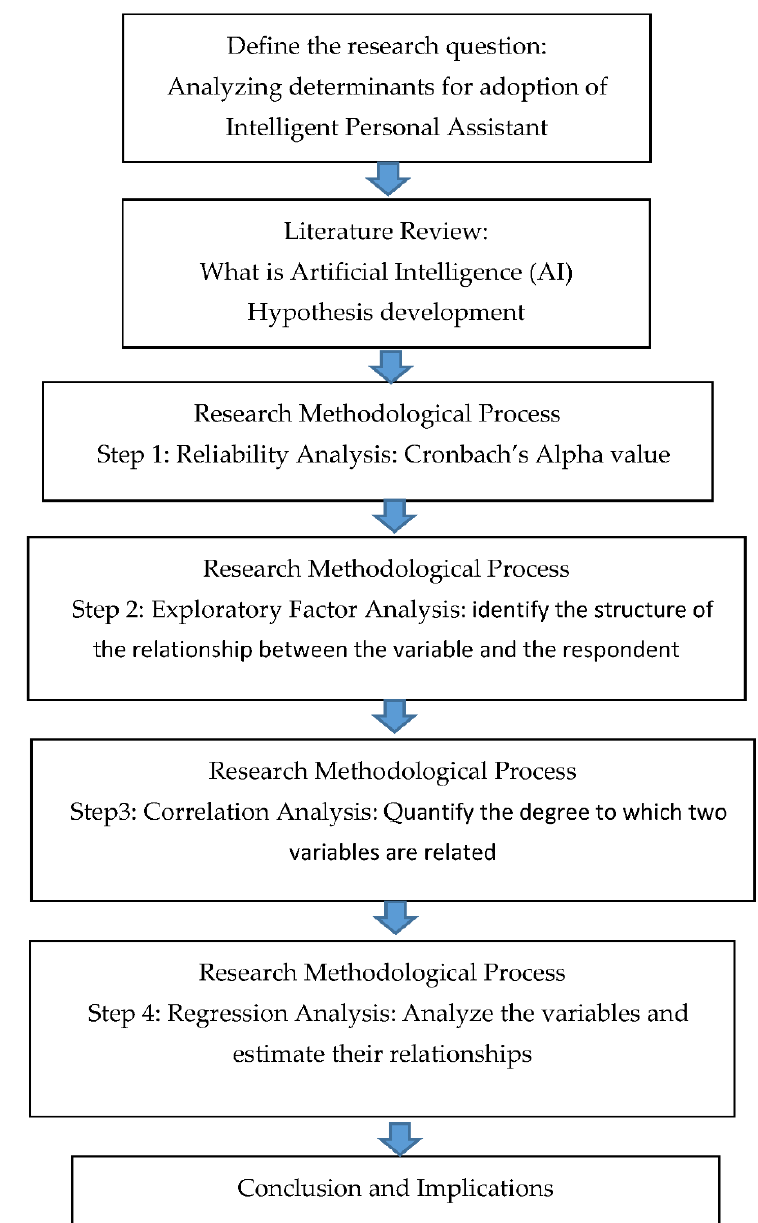
Figure 2. Research flowchart.